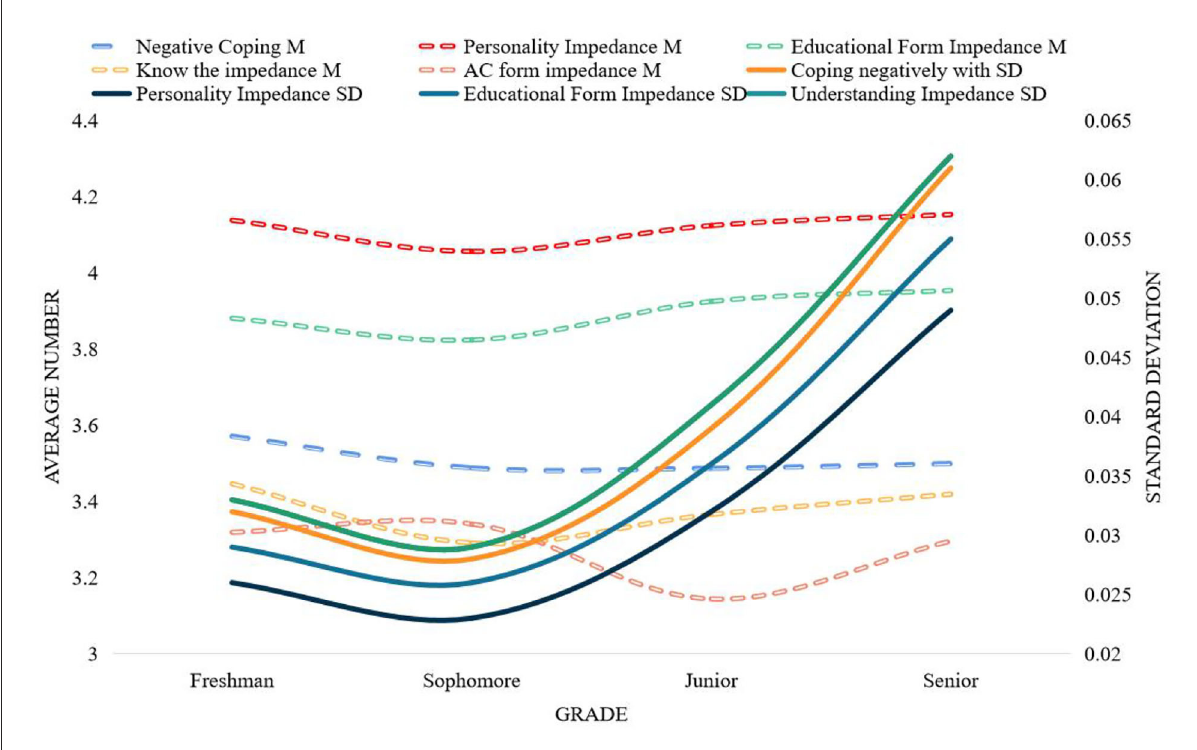
FIGURE6 Mean and standard deviation of each factor score for